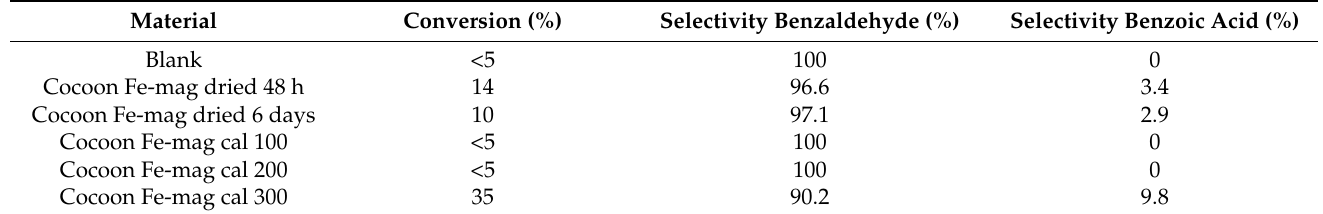
Table 1. Benzyl alcohol oxidation using 50 mg of catalyst, 2 mL of acetonitrile, 0.2 mL of benzyl